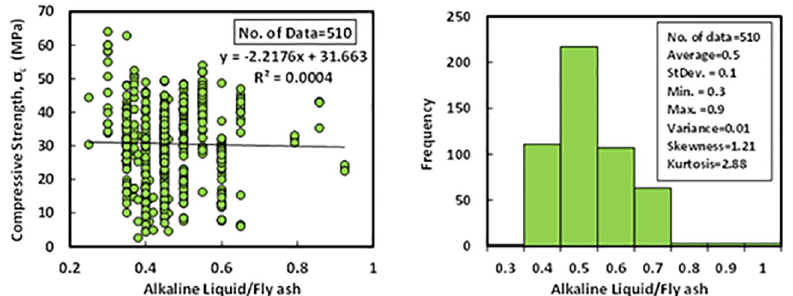
Fig 3. Variation between compressive strength and (alkaline liquid/fly ash) ratio with a histogram of fly ash-based geopolymer concrete mixtures.